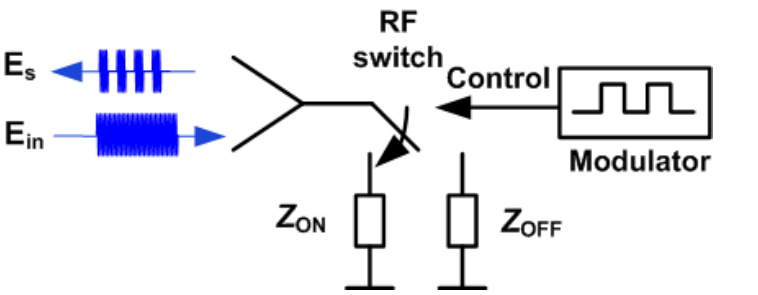
Figure 4. Block diagram of a passive modulated backscatter in reflection based on a microwave